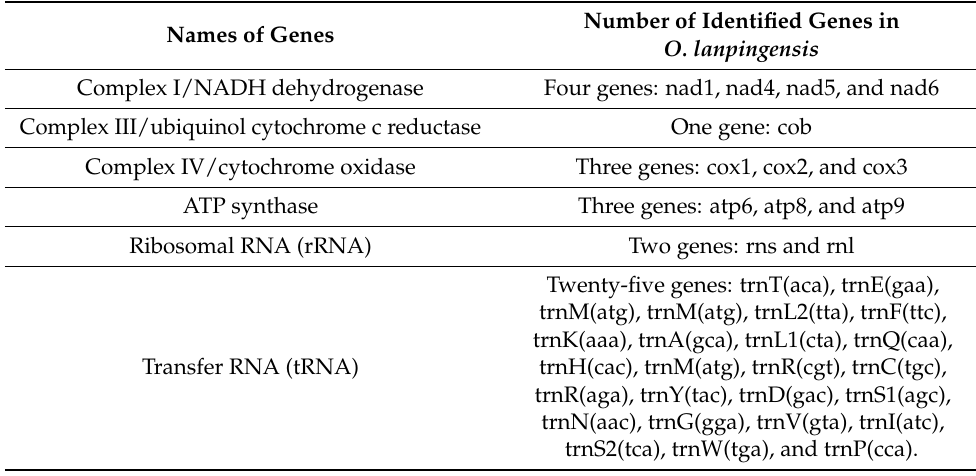
Figure 2. Circular map of the complete mitogenome of O. lanpingensis constructed using Organellar Genome DRAW. All functional genes were in the same strand. The mitogenome coordinates had 24 standard protein-coding genes (PCGs), 23 transfer RNA (tRNA) genes, and 2 ribosomal RNA (rRNA) genes. Table 2. Summary of the gene content of the O. lanpingensis